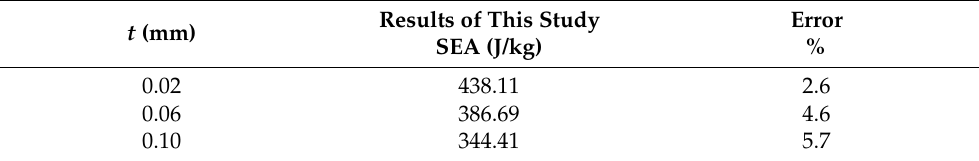
Table 2. Comparison of SEA.